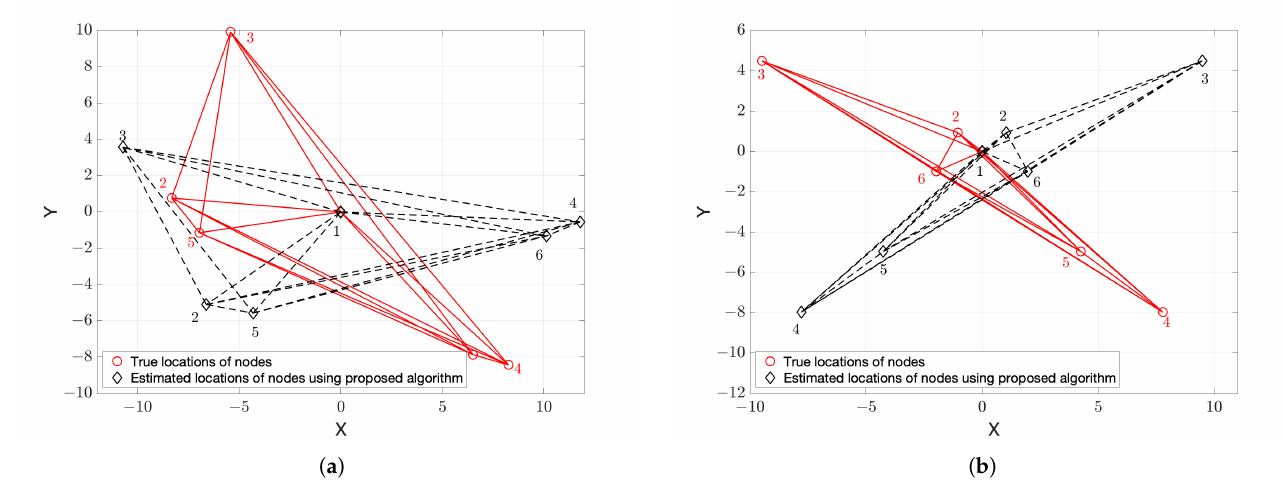
Figure 1. Illustration of the positions of nodes calculated via multidimensional scaling (MDS), where red circles are the desired position (randomly generated) and black diamonds are the output of MDS. ( a ) rotation ambiguity only; and, ( b ) rotation and flip